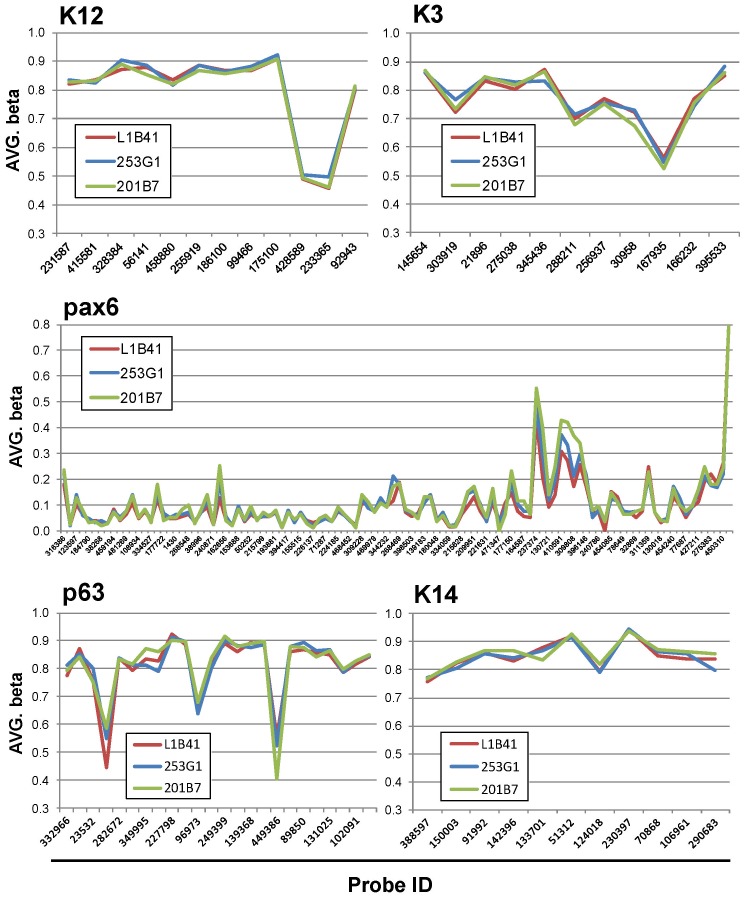
DNA methylation analysis of corneal epithelium-related genes.Methylation analysis of individual genes was performed. Methylation frequency in K12, K3, Pax6, p63, and K14 genes were not statistically different among L1B41, 253G1, and 201B7 (significance level; p<0.001 [ = diffscore >33 or <−33]).